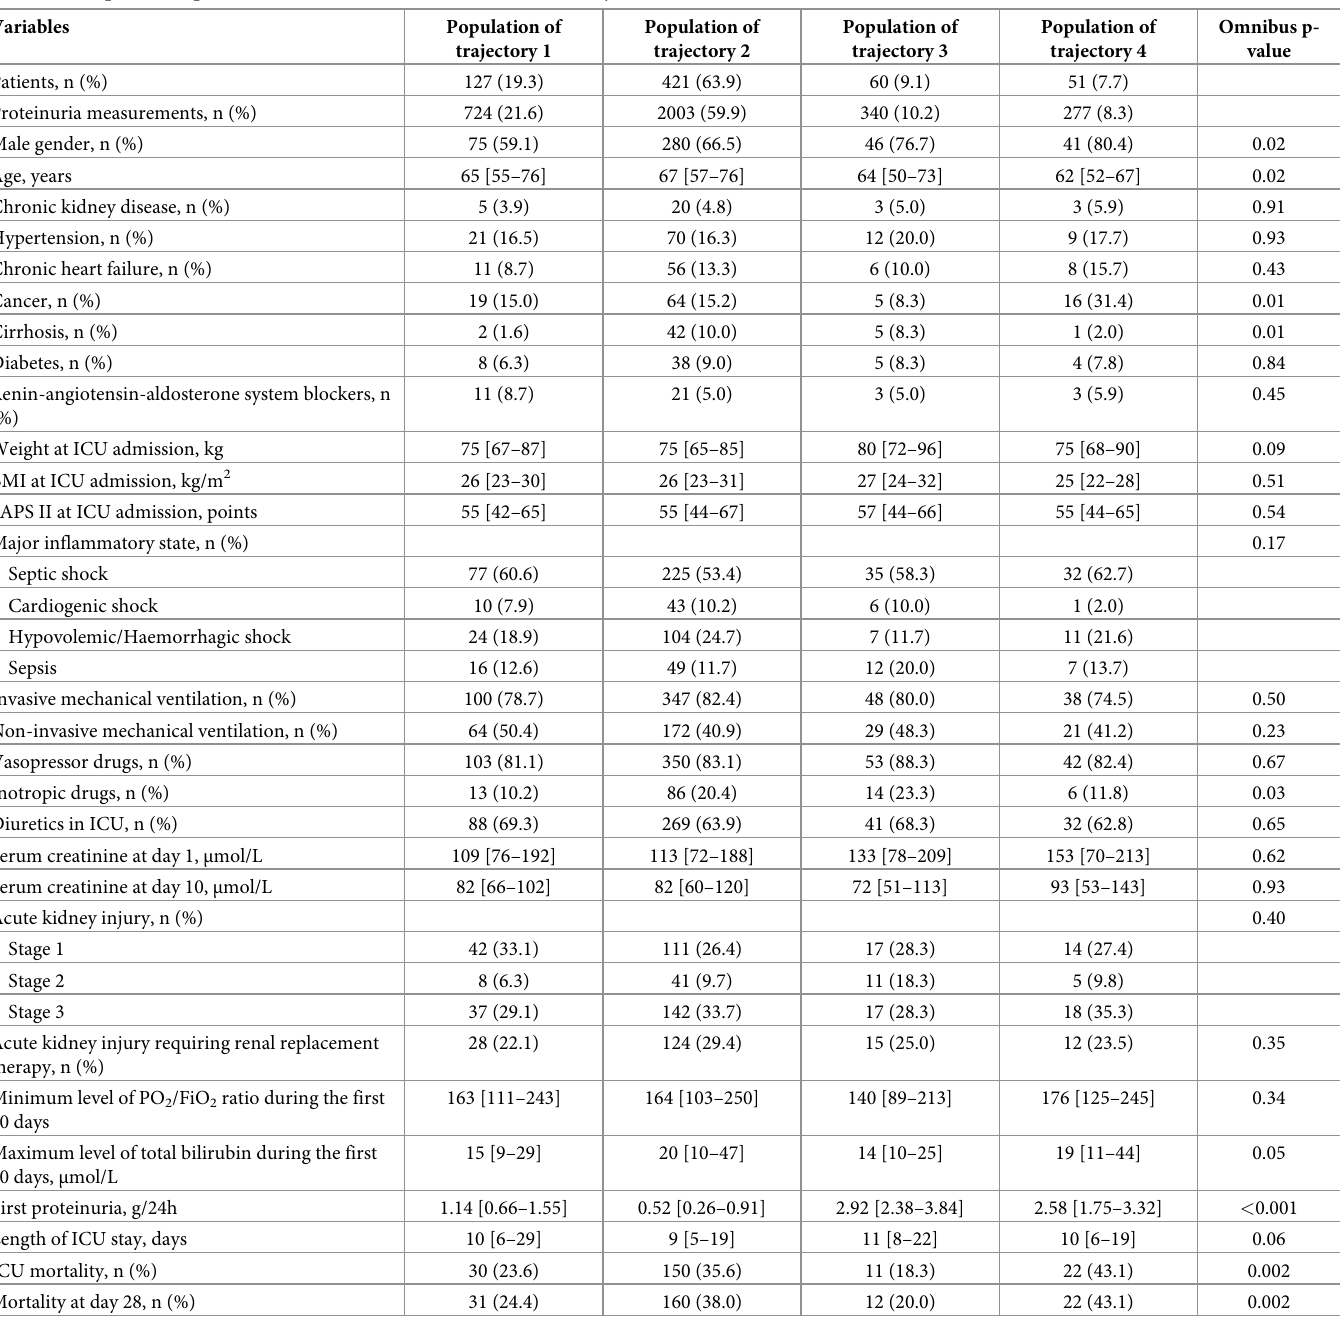
Table 2. Comparison of patient characteristics associated with the four